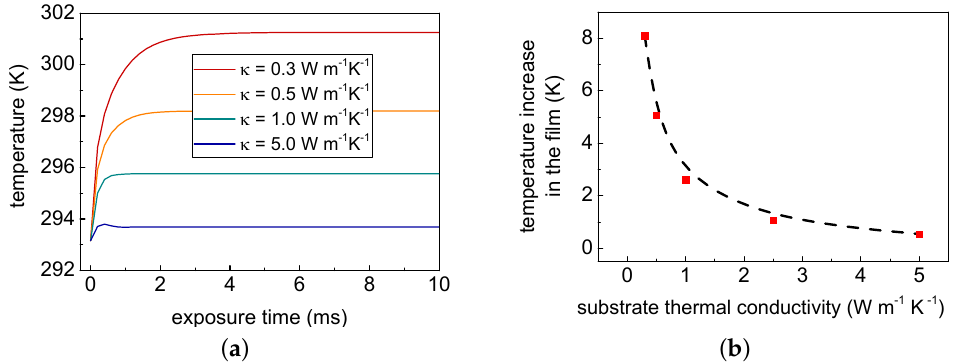
Figure 9. Temperature increase in the FSS on polyimide substrate under the 0.1 THz, obtained for different thermal conductivity of the substrate. ( a ) time dependence of temperature. ( b ) saturation temperature value at 10 ms as a function of thermal